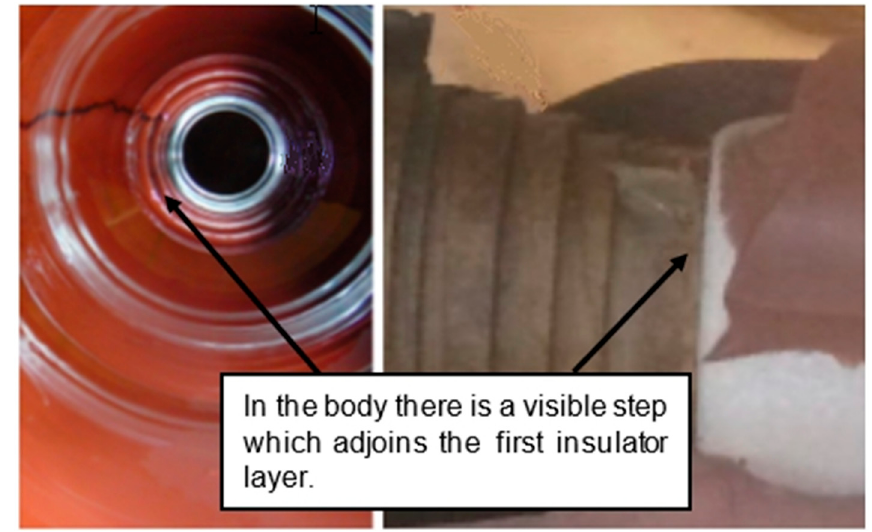
Figure 6. Excessive fit of the capacitor part of the bushing inside the housing.